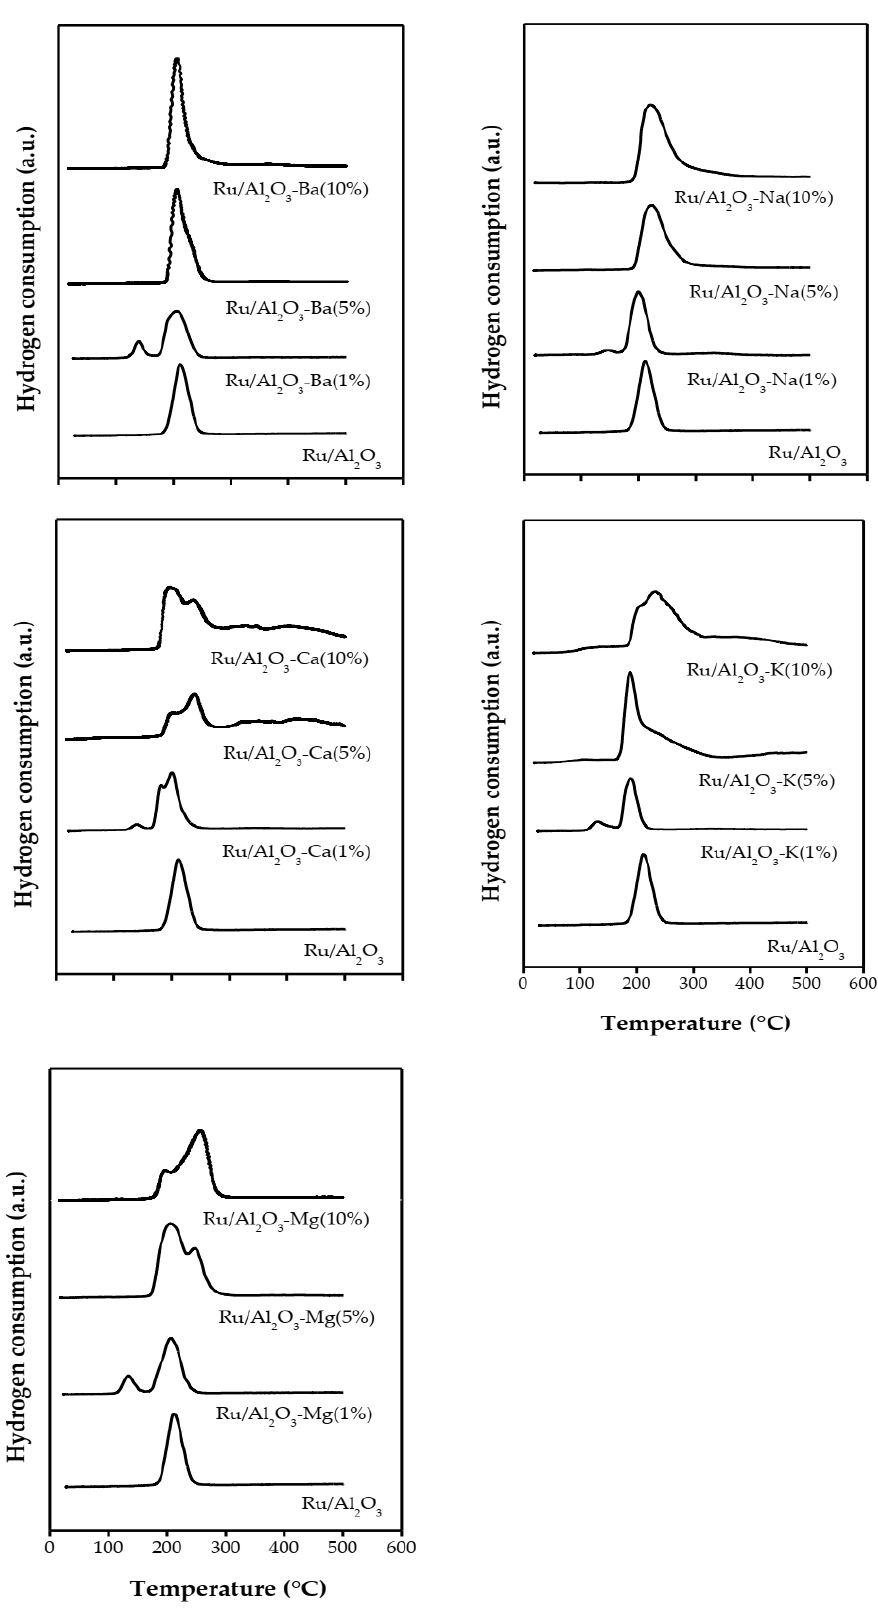
Figure 2. TPR profiles of Ru/Al 2 O 3 -A/AE(1, 5, and 10 wt%) catalysts.